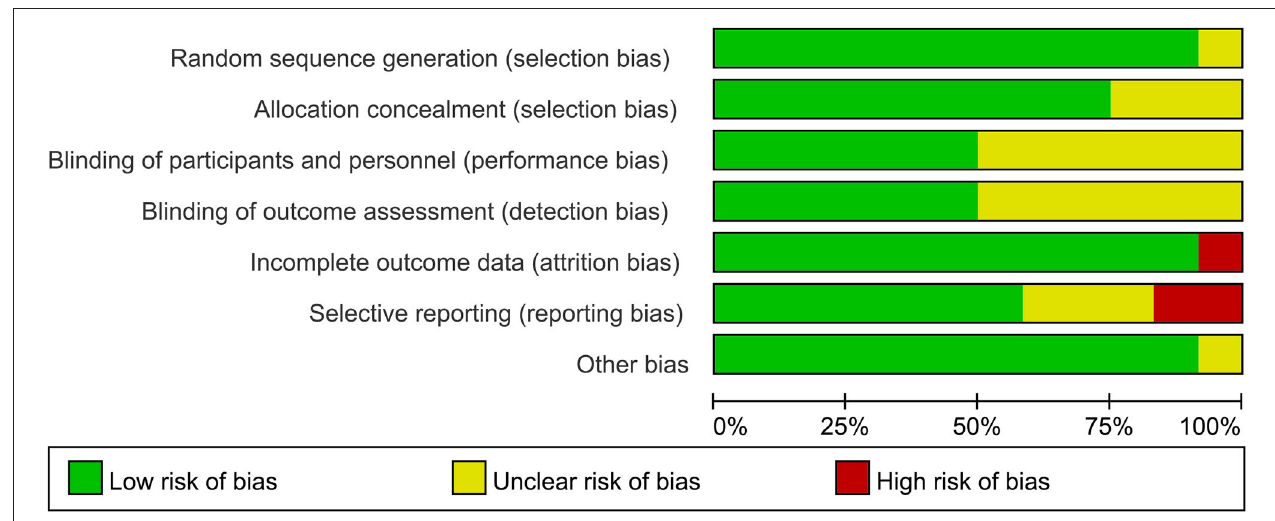
FIGURE 3 | Risk of bias graph of review authors’ judgments about each risk of bias item presented as the percentage across all included